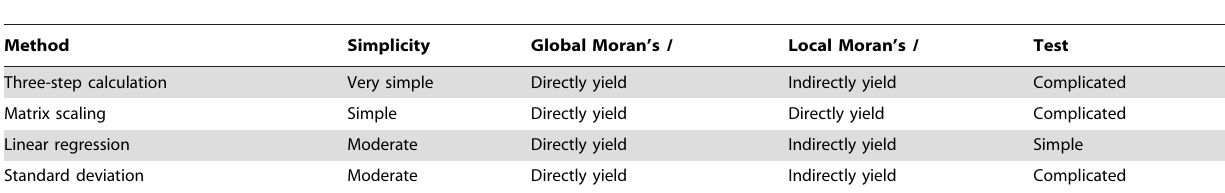
Table 2. Comparison of the advantages and disadvantages of the four methods.